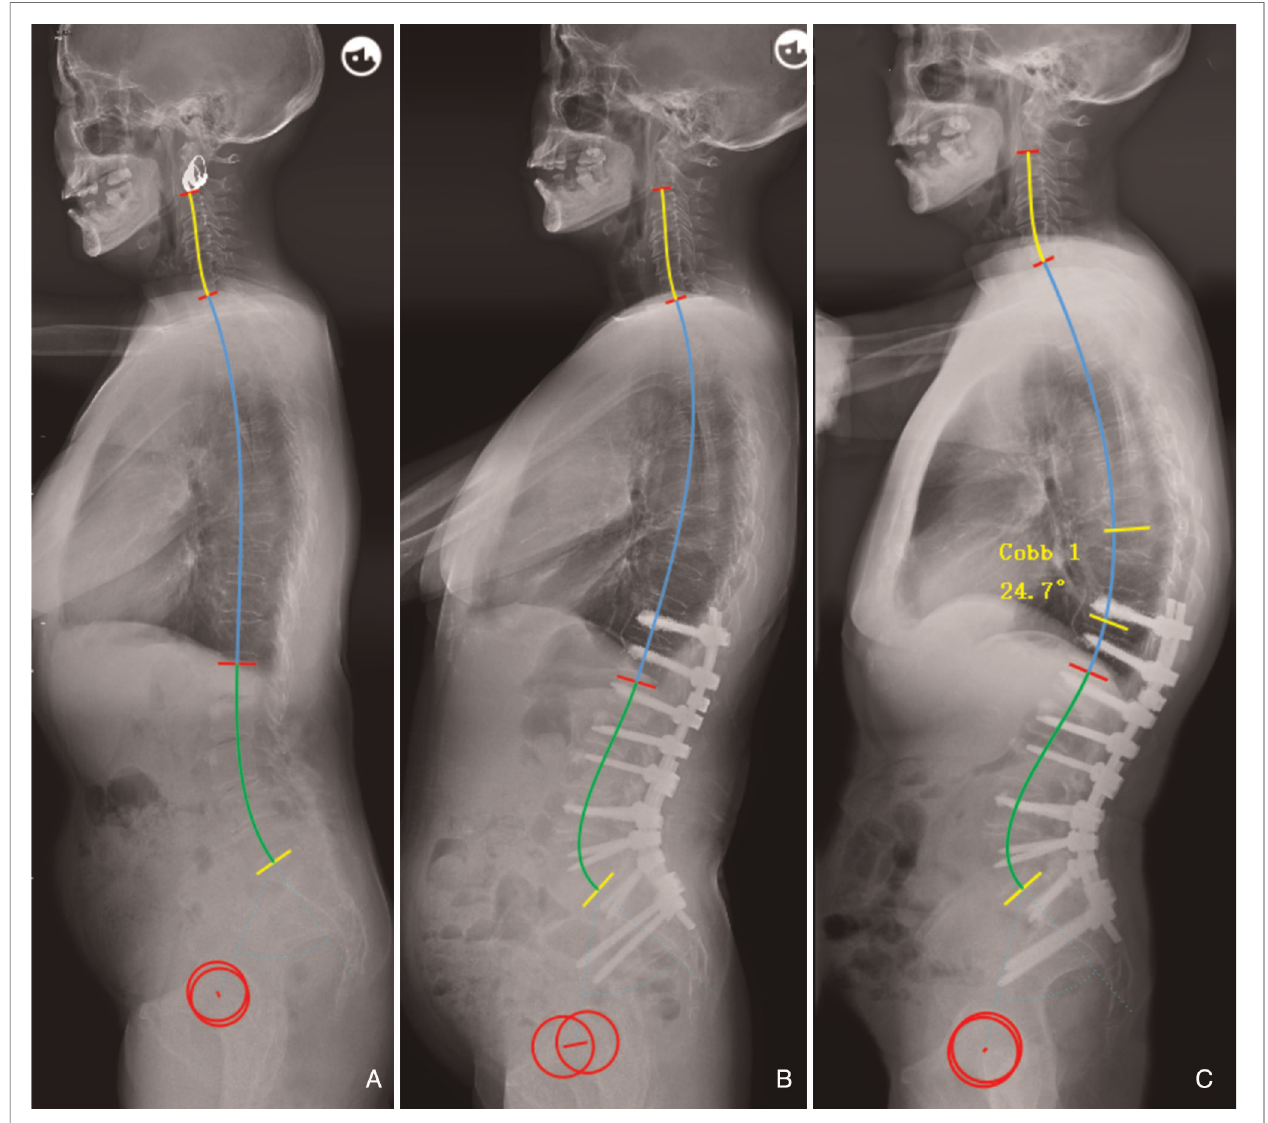
FIGURE 5 | 66-year-old female. ( A ) preoperative sagittal standing full spine X-rays, pelvic incidence (PI)=57.6°, thoracic kyphosis (TK)=19.9°, lumbar lordosis (LL)= − 36.1°. ( B ) immediate postoperative X-rays, pelvic incidence=56.6°, thoracic kyphosis=27.1°, lumbar lordosis (LL)= − 65.1°; ideal LL=0.7*56.6+0.4*27.1+1= − 51.5°, Δ LL=65.1 – 51.5=13.6°. ( C ) PJK occurred at 6-month